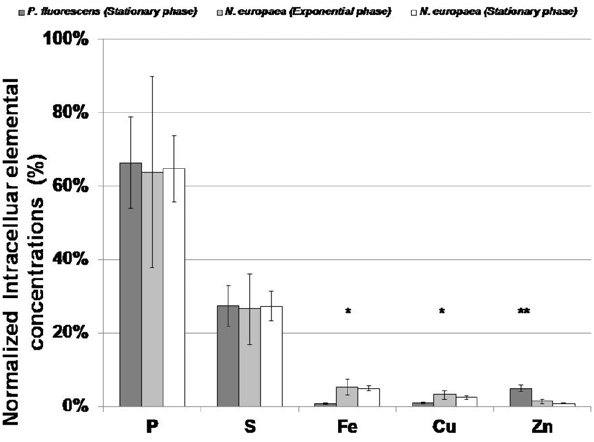
Figure 5. Comparison of elemental profiles in exponential and stationary phase cultures of N.europaea with stationary phase cultures of P.fluorescens [ 5 ] . Error bars depict standard deviation of 5–9 replicates in this study and 5 replicates in [5]. * represents the elements for which the molar fractions in N. europaea were statistically higher ( a =0.05). ** represents the elements for which the molar fractions in N. europaea were statistically lower ( a =0.05). The molar fractions of remaining elements were statistically not dissimilar ( a =0.05).